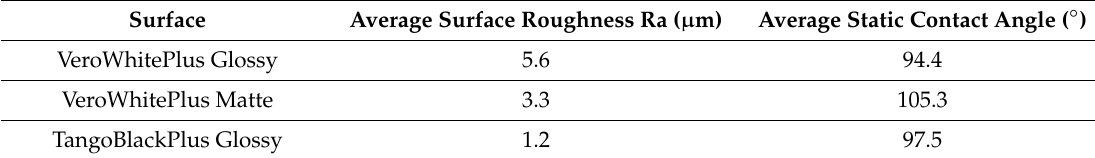
Figure 5. 3D images of the surface topography of the printed surfaces, ( a ) VeroWhitePlus, glossy, ( b ) VeroWhitePlus, matte, ( c ) TangoBlackPlus, glossy, ( d ) TangoBlackPlus matte. Table 1. Surface roughness and contact angles of printed materials.